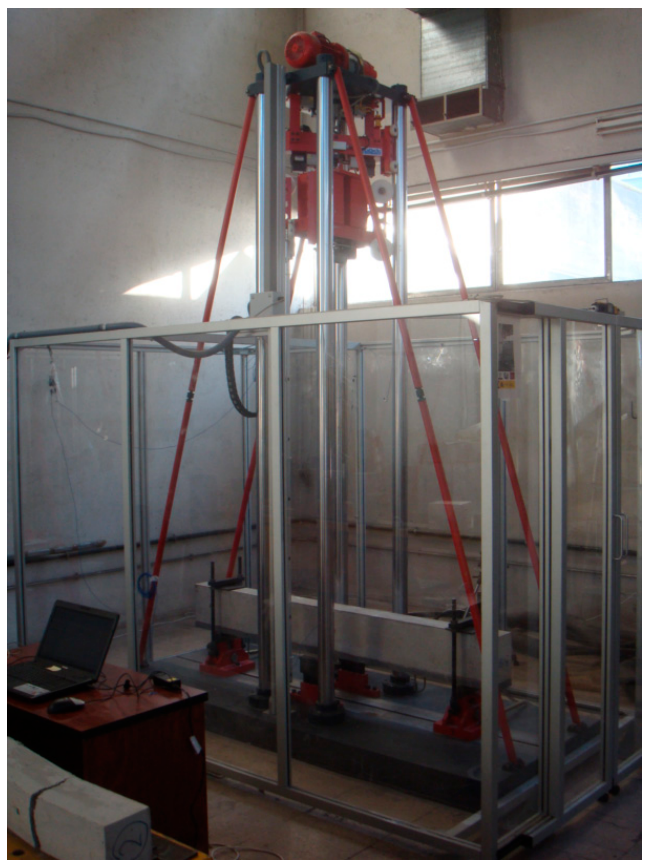
Figure 2. Overview of an impact test at Technical University of Madrid, Spain (UPM).